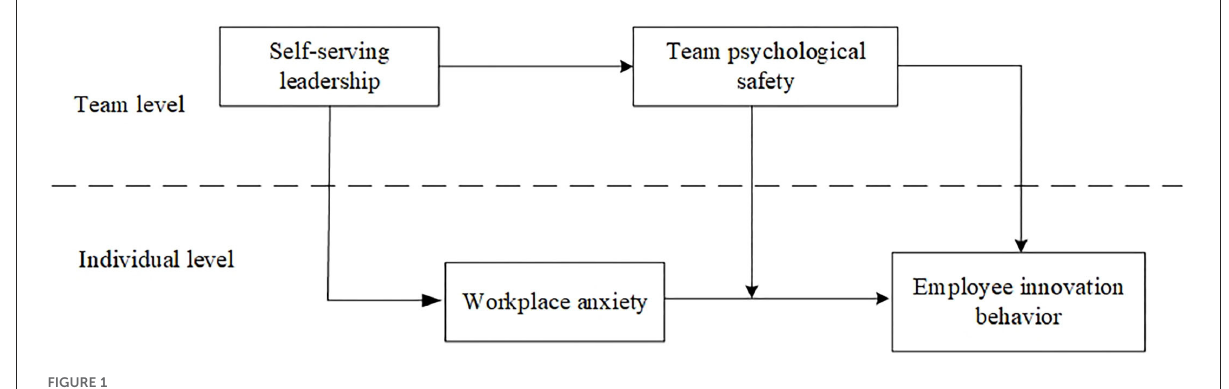
FIGURE1 Theoretical